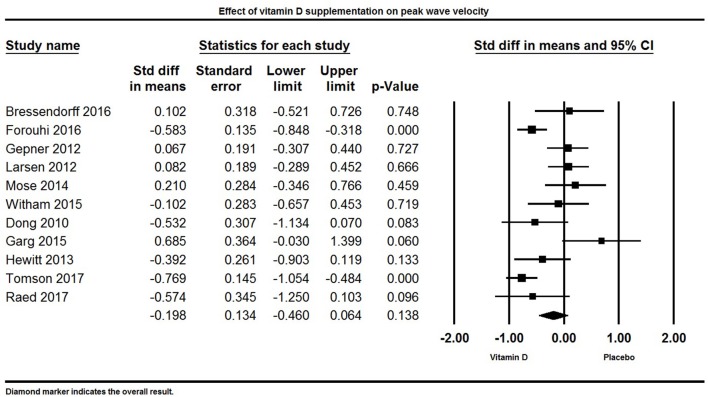
Forest plot detailing standardized mean difference for the impact of vitamin D on peak wave velocity.